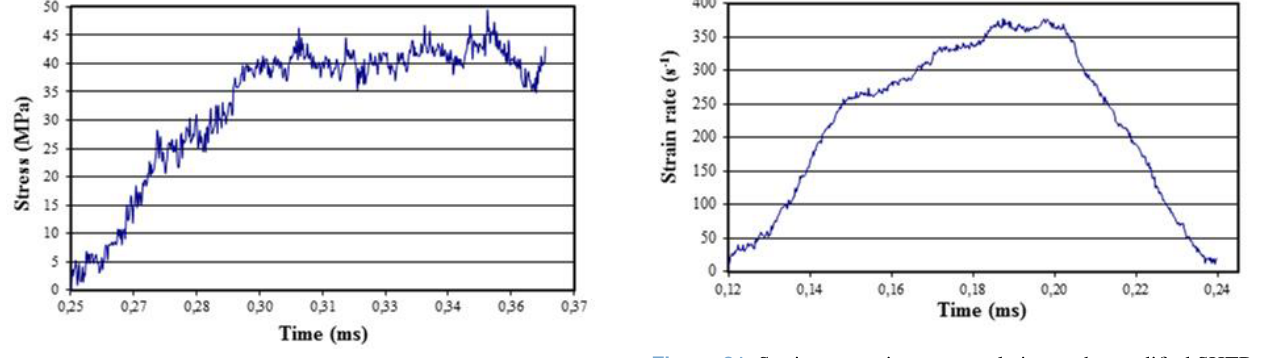
Figure 19. Transmitted stress wave relating to the modified SHTB without the interruption fixture (Model 2) at a pressure equal to 3.5bar.